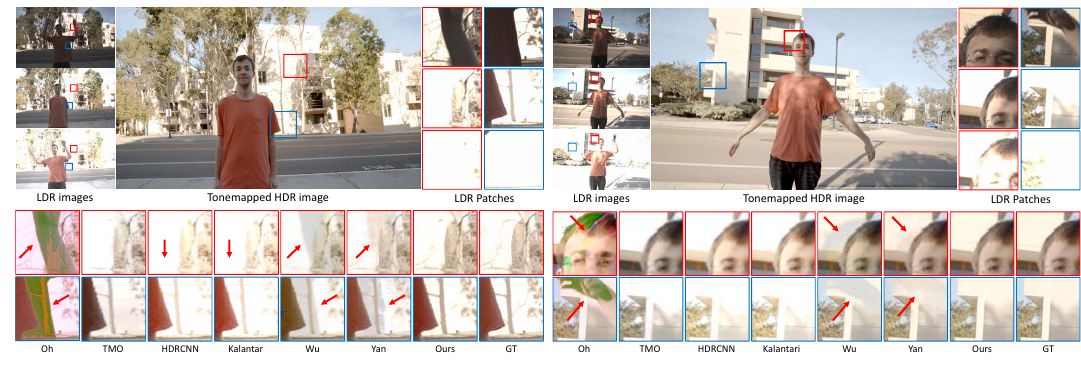
Figure 6. Visual comparisons on ( a ) testing 007 data and ( b ) testing 008 data from from Kalantari’s dataset. In the top section, we present the input LDR images, tonemapped HDR image produced by the proposed method, and LDR image patches. In the bottom section, we compare magnified local patches of the HDR images generated by our method and the state-of-the-art methods. Our network produces high-quality HDR images in the presence of saturation and object